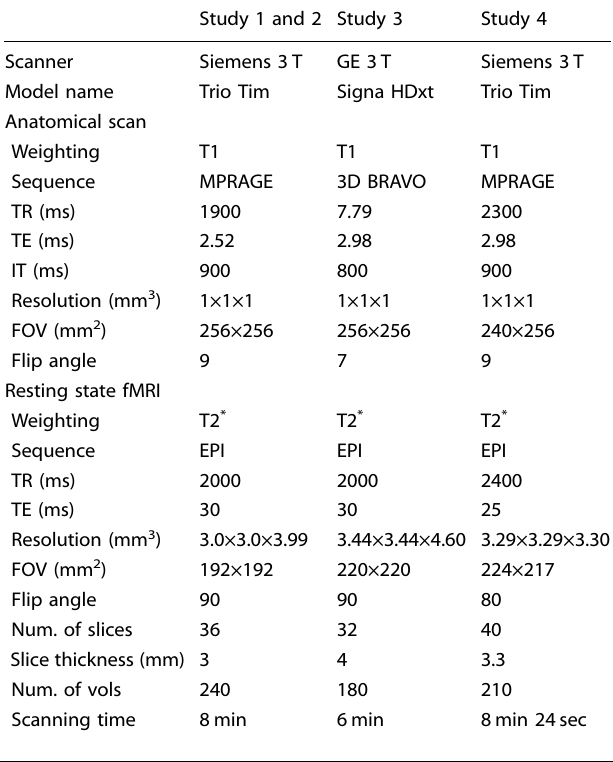
Table 2. Scanners and scanning parameters for each